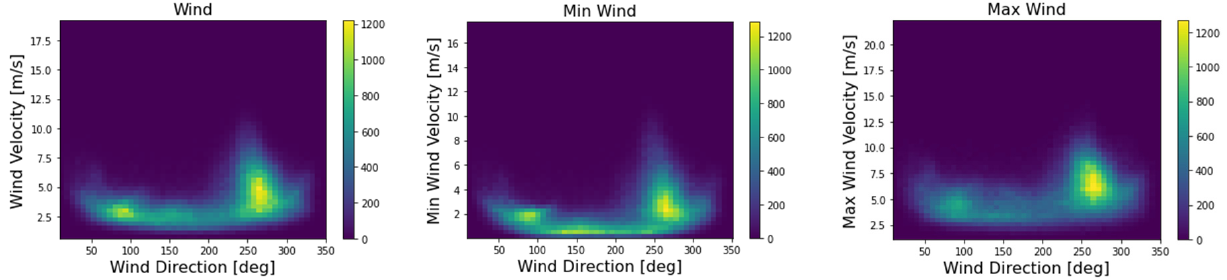
Figure 3. Visualization of the frequency of occurrences wind of given speed in given directions.